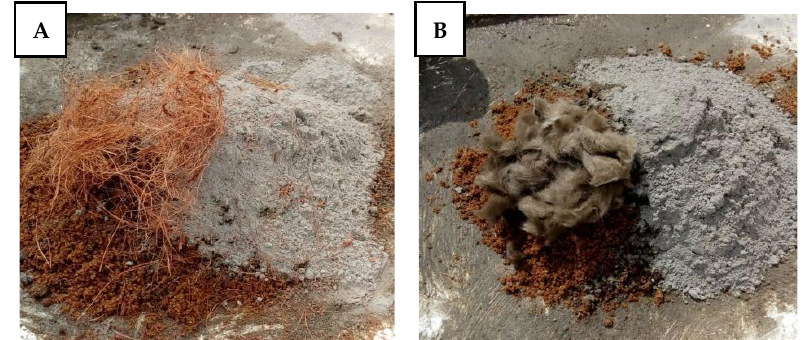
Figure 2. Mix configurations: ( A ) Coconut fibres + fine aggregate + cement; ( B ) Mineral wool fibres + fine aggregate + cement.